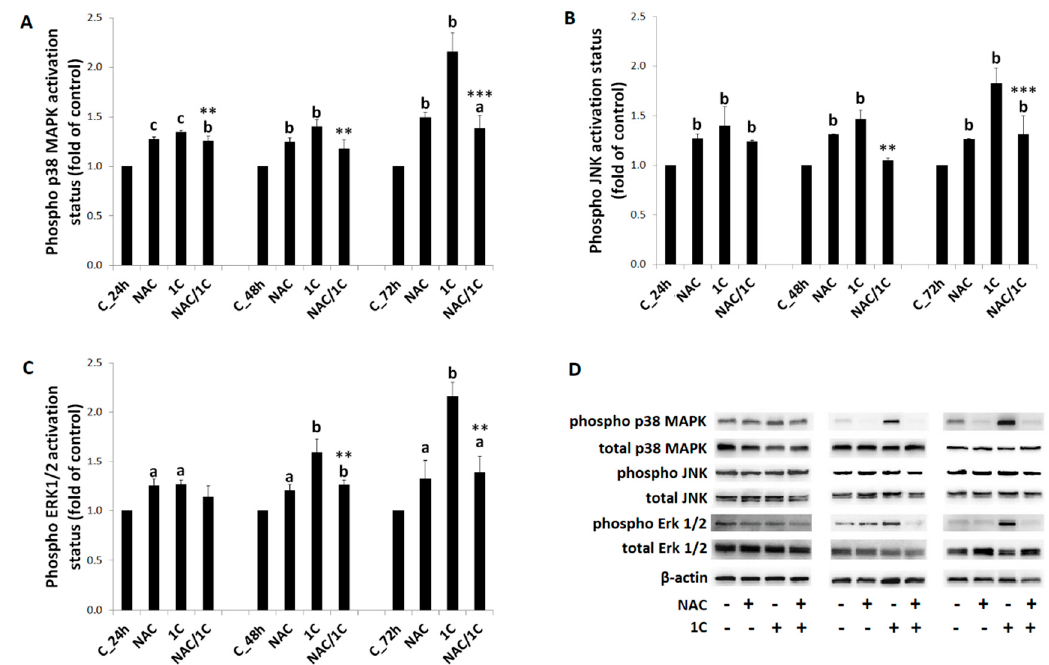
Figure 11. Phosphorylation status of mitogen-activated protein kinase (MAPK) proteins. Phosphorylation changes of p38 MAPK ( A , D ), JNK ( B , D ), and ERK1/2 ( C , D ) as the result of 1C or NAC/1C combination treatment. Significantly different a p < 0.05, b p < 0.01, c p < 0.001 vs. untreated cells (control); ** p < 0.01, *** p < 0.001 vs. 1C.